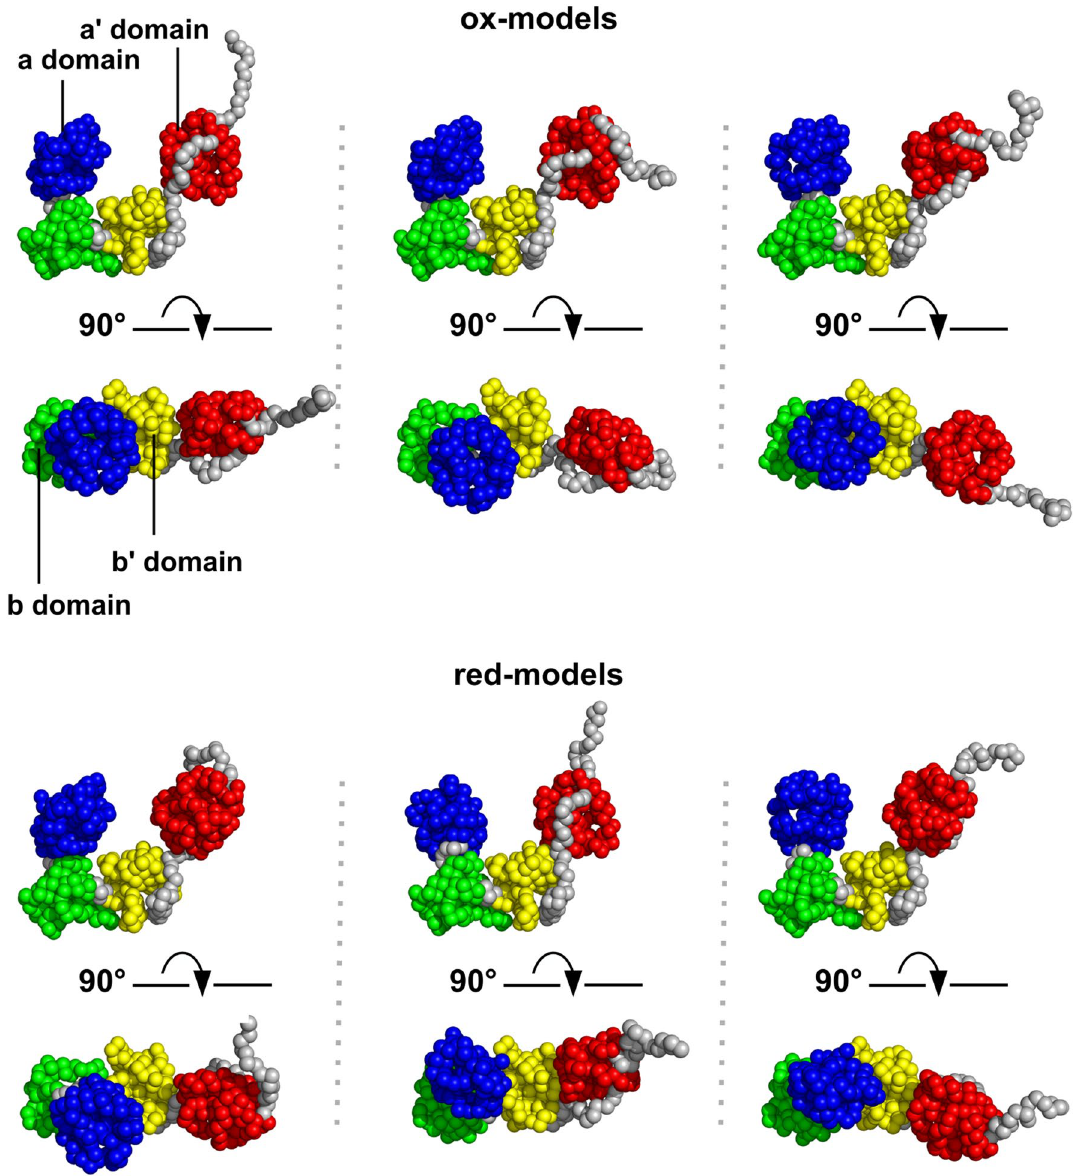
Figure 2. Oxidized ER-60 (ox-models) and reduced ER-60 (red-models) models. A total of six models were taken for oxidized and reduced ER-60 (three each) from the extracted ox- and red-models and are shown from two viewpoints. Here, the a , b , b ′ , a ′ domains and the inter-domain regions are coloured in blue, green, yellow, red, and gray,